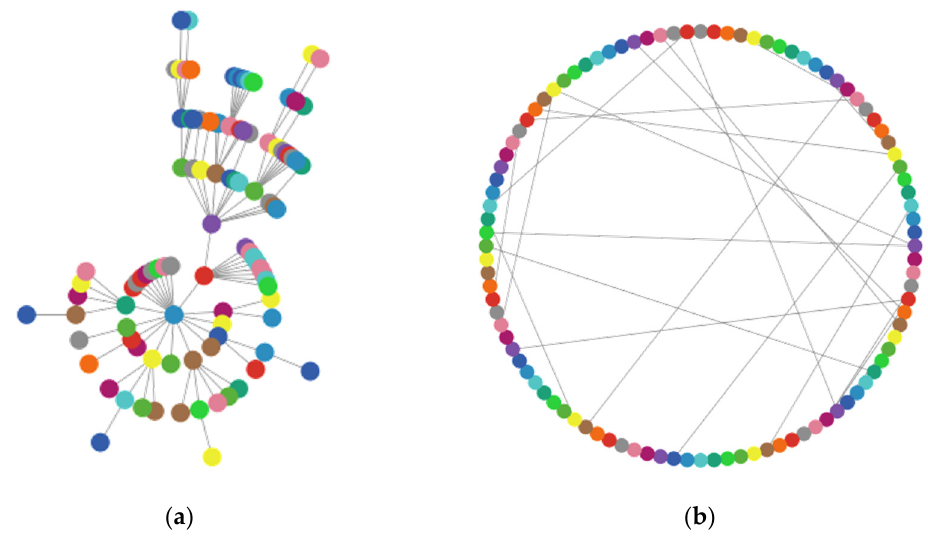
Figure 6. ( a ) Scale-free network; ( b ) small-world network. In the scale-free network, the graph is generated using the Barabási–Albert model. This network has the property of being “scale-free”: the distribution of degrees (i.e., the number of links for each turtle) follows a power law. The minimum degree is 1 — each newly added node creates an edge with the existing nodes.